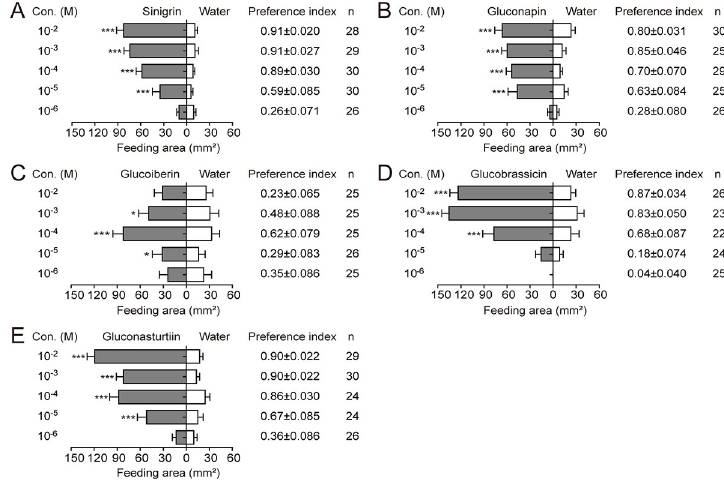
Fig 1. Feeding preference of the fifth instar larvae of P . rapae to glucosinolates. Cowpea leaf discs were used as the substrate for the two choice assays of fifth instar P . rapae larvae. The upper surface of each disc was treated with 20 μ L of glucosinolate solutions. Each control disc was supplied with the same volume of water. The concentration gradients of ( A ) sinigrin, ( B ) gluconapin, ( C ) glucoiberin, ( D ) glucobrassicin, and ( E ) gluconasturtiin all ranged from 10 − 6 to 10 − 2 M. When the total feeding area was larger than 25% or after 24 h feeding, the area of each disc consumed by larvae was measured, and the feeding preference index was calculated. Differences in feeding amounts on treated and control discs were tested by paired Student’s t -test. n represents the replicates of larvae and are labeled in the figures. Data are presented as mean ± SEM. � P < 0.05, �� P < 0.01, ��� P < 0.001.